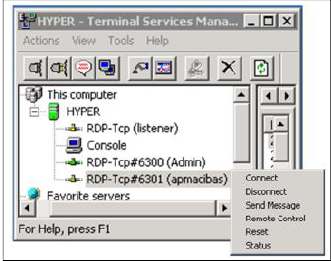
Fig. 6. Interception of trainee’s session on the server by the trainer with administrator’s